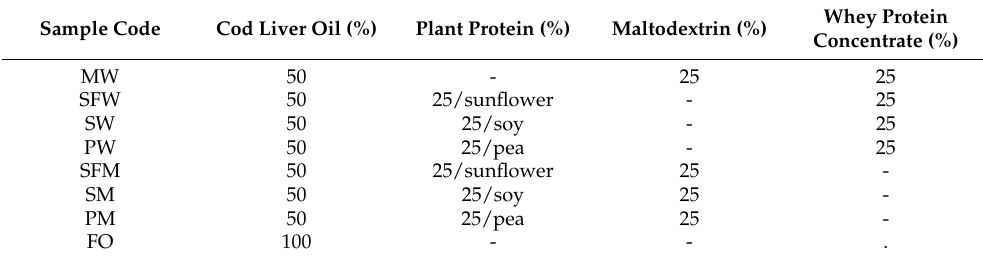
Table 4. Sample codes and dry matter composition of spray-dried emulsion and non-encapsulated fish